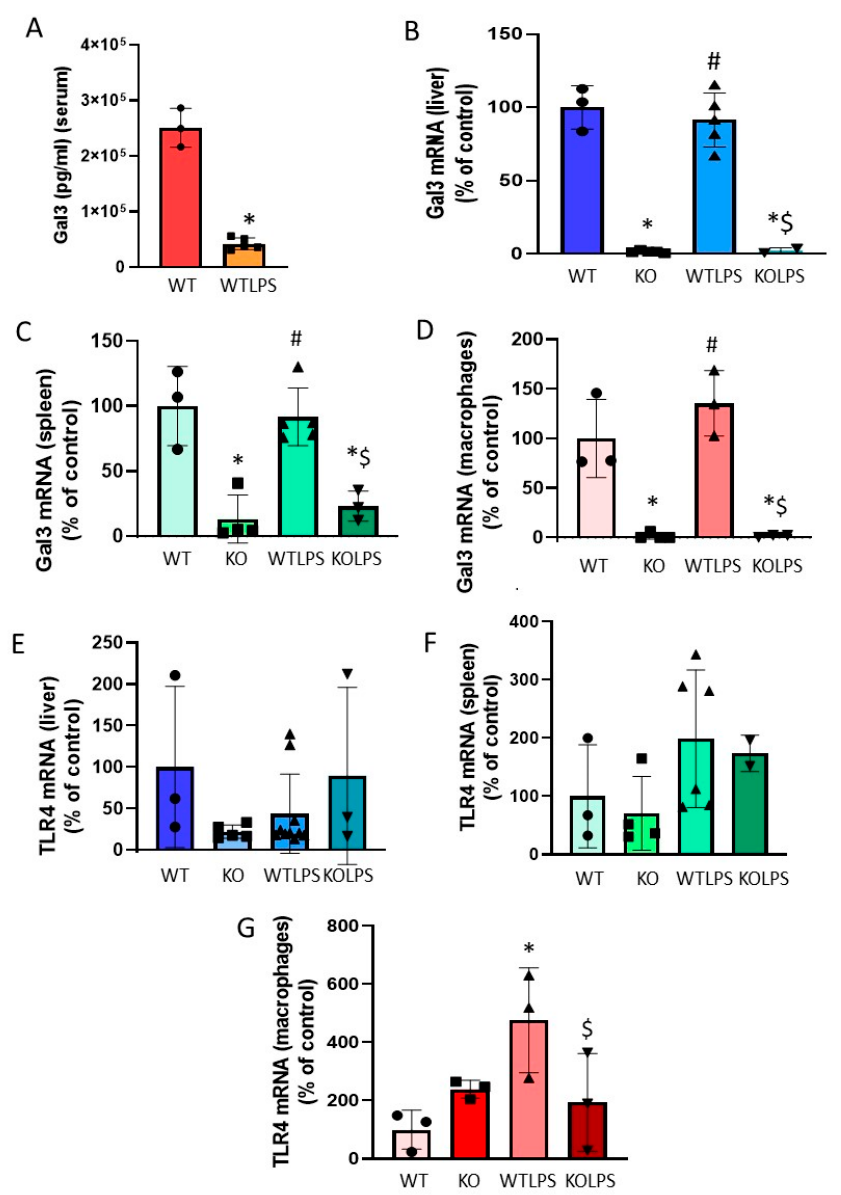
Figure 3. Determination of Gal3 and TLR4. ( A )The expression of Gal3 in serum was measured by ELISA. Blood samples were collected from the heart of mice 1 h after LPS/saline injection. Results are mean ± SD of N = 4–6 animals, expressed as ng/mLof the analyzed protein and relative to the WT group. Statistical significance (two tailed Student’s t test): p < 0.001. Using RT-PCR, the mRNA expression of Gal3 was measured in the liver ( B ), spleen ( C ), and peritoneal macrophages ( D ). Using RT-PCR, the mRNA expression of TLR4 was measured in the liver ( E ), spleen ( F ), and peritoneal macrophages ( G ). For PCR analysis, animals were culled 1 h after LPS/saline injection. Results are mean ± SD of N = 3–10 animals, normalized to β -actin and expressed as relative expression to the WT group.Statistical significance (one-way ANOVA followed by the LSD post hoc test for multiple comparisons): * -compared with WT group; # -compared with KO group; $ -compared with WTLPS group; p < 0.001 for ( B – D ), p < 0.05 for ( G ). Abbreviations: WT, wild type mice; KO, Gal3 knockout mice; WTLPS, wild type mice treated with LPS; KOLPS, Gal3 knockout mice treated with LPS.